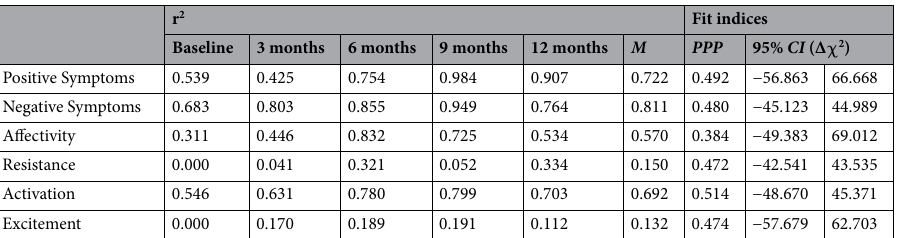
Table 2. Proportions of variance explained by trait differences (r 2 ) in BPRS subscales. r 2 proportions of between the observed and the replicated chi-square values (positive upper levels of the CI indicate good fit).